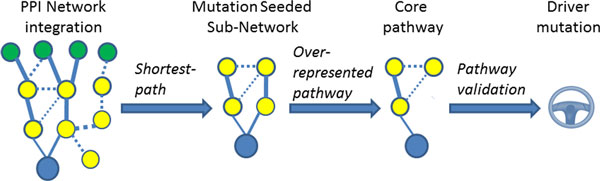
Workflow to determine core pathways and driver mutations. (A) mutated genes (blue filled circle) and differentially expressed genes (green filled circle) are mapped to a protein-protein interaction network in which the circles and lines represent proteins and interactions between them, respectively. (B) The shortest-path algorithm is applied to construct subnetworks by linking the mutated genes to up-, or down-regulated genes, respectively. (C) BiNGO is applied to identify overrepresented biological pathways. (D) The experimentally validated driver pathway is used to rank the driver mutations.